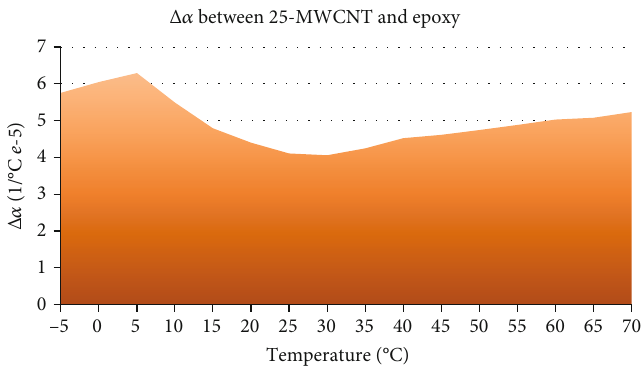
Figure 3: CTE di ff erences between 25-MWCNT and epoxy ( Δα ) at a temperature range of -5 ° C to 70 ° C.